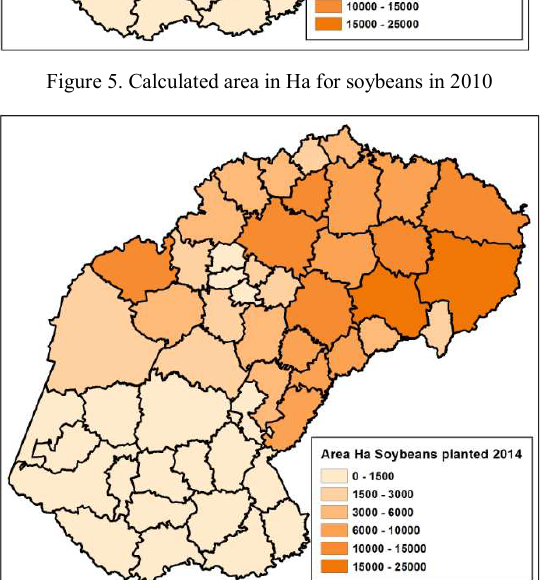
Figure 6. Calculated area in Ha for soybeans in